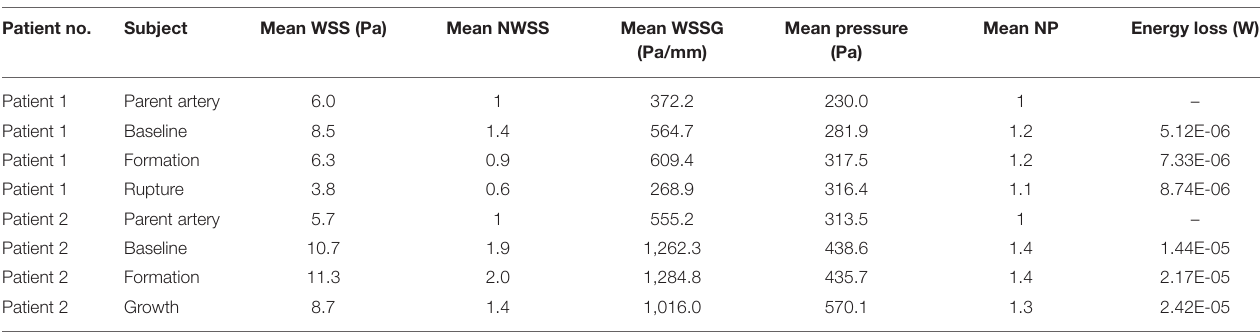
TABLE 1 | The hemodynamic parameters result of included patients. Patient